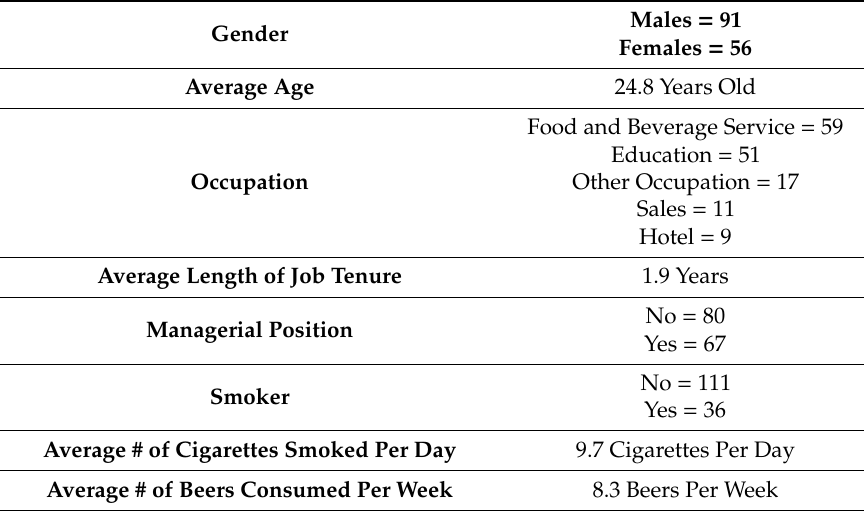
Table 2. Demographic Response Totals.